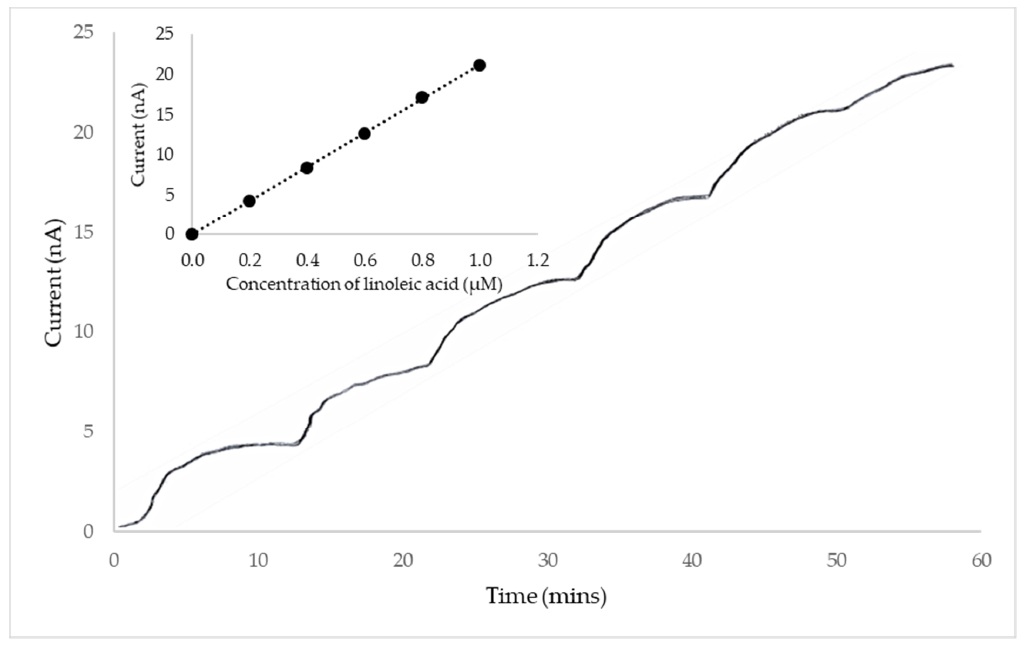
Figure 6. Amperometric responses at a cobalt phthalocyanine screen-printed carbon electrode with 15 units of lipoxygenase, obtained following 5 additions of 0.2 µM linoleic acid, with standard addition plot (insert).